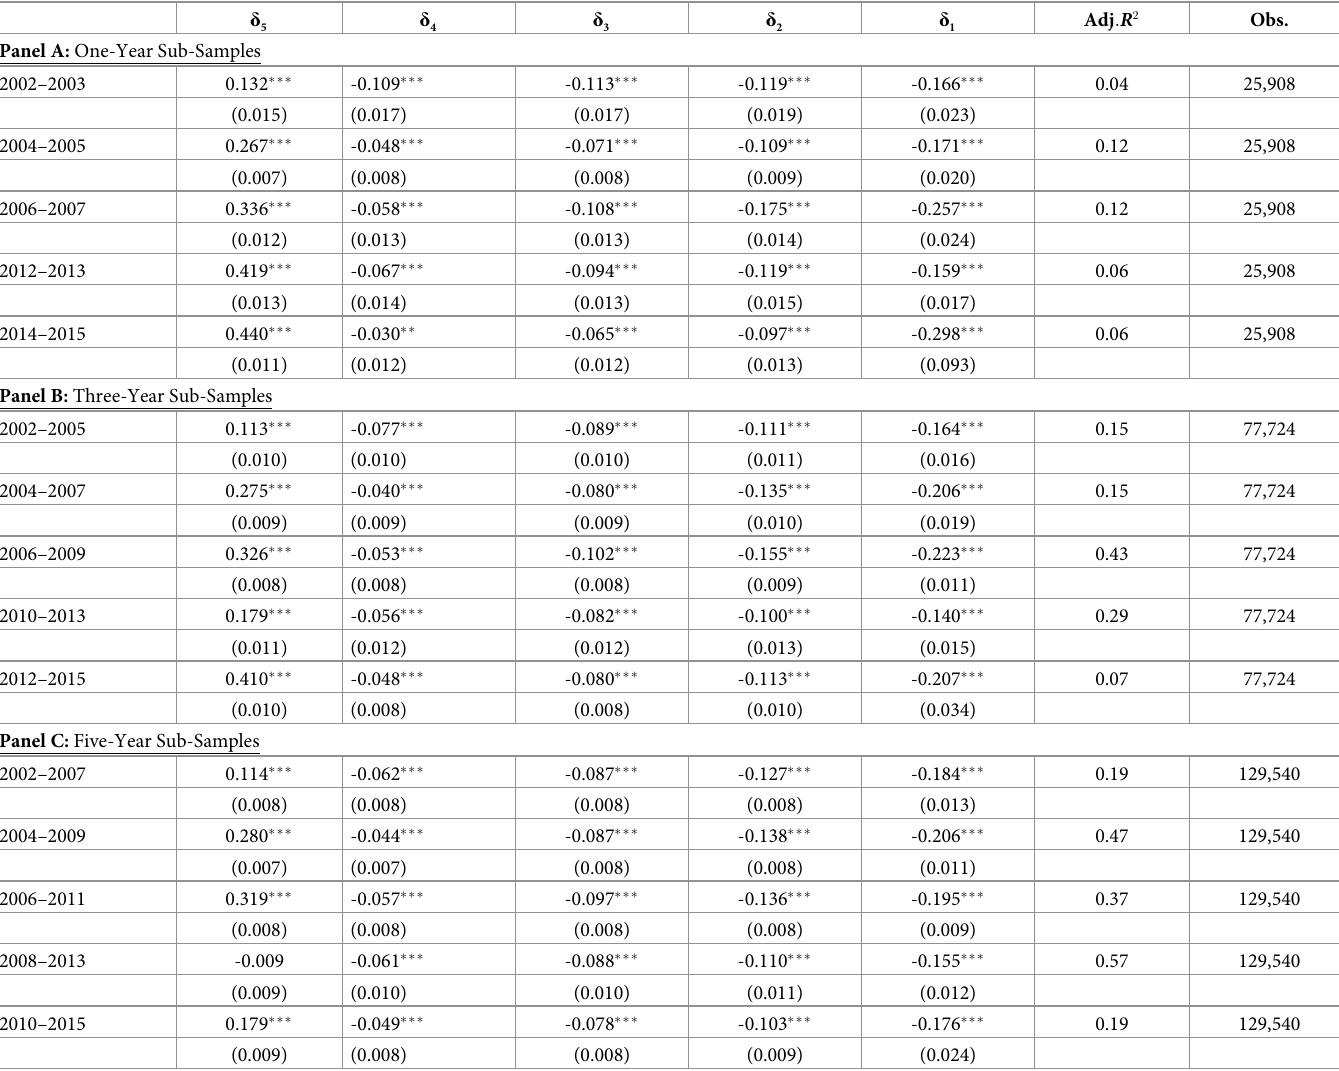
Table 4. Panel regression results derived from Morningstar ratings where the Sharpe ratio measures out-of-sample